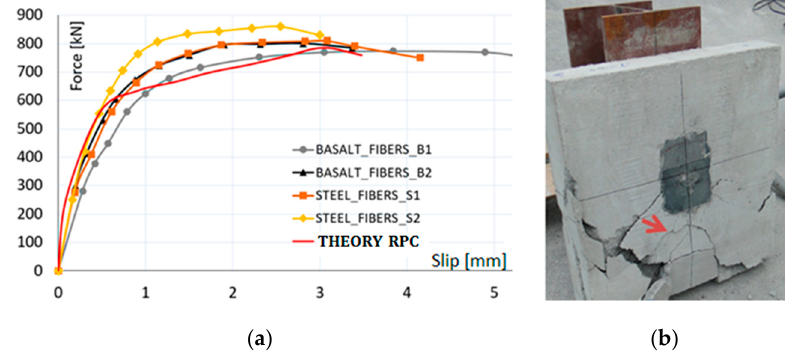
Figure 10. Load-slip curves of the RPC specimens ( a ) and failure mode ( b ).